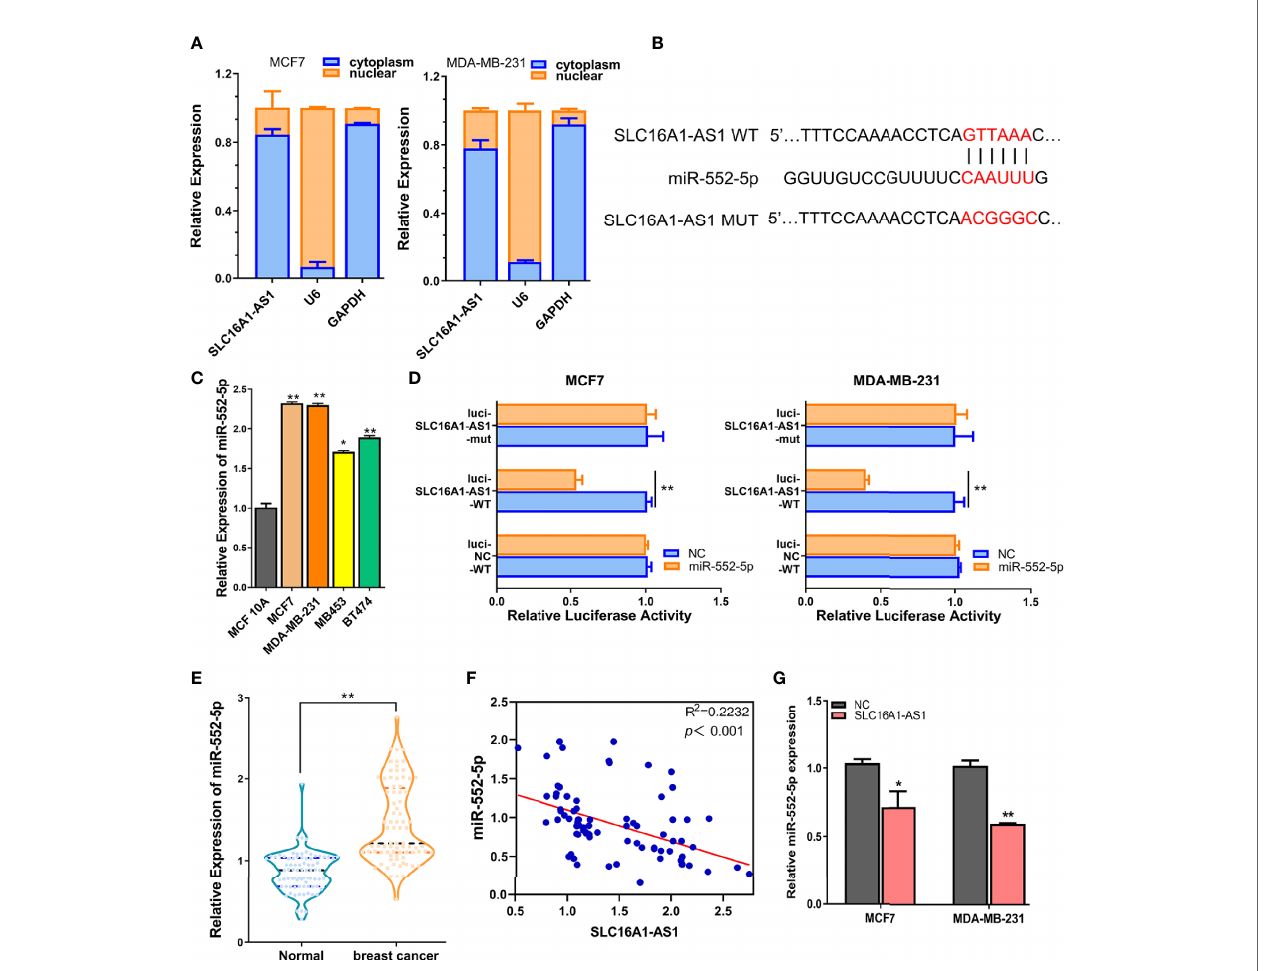
FIGURE 4 | SLC16A1-AS1 is a sponge for miR-552-5p. (A) Cellular sublocalization of SLC16A1-AS1 in MCF7 and MDA-MB-231 cells was investigated with nuclear and cytoplasmic separation assay, and GAPDH and U6, respectively, acted as internal controls for cytoplasmic and nuclear expressions. (B) Diagram indicating the prospective binding sites for miR-552-5p with SLC16A1-AS1 predicted by miRDB (http://mirdb.org/) and mutated information of prospective miR- 552-5p binding sites. (C) miR-552-5p expressions were signi fi cantly higher in MCF7 and MDA-MB-231 cells than in MCF 10A cells analyzed by qRT-PCR. (D) Dual-luciferase activities in MDA-MB-231 and MCF7 cells in the presence of negative control (NC), wild type (WT), or mutated (mut) reporter of SLC16A1-AS1 with miR-552-5p or without (NC) miR-552-5p mimics. (E) miR-552-5p expression was considerably higher in BC tissues versus the paired paracancerous tissues from 80 BC patients (the same specimens used in Figure 1A ). (F) miR-552-5p expression level was signi fi cantly negatively related to SLC16A1-AS1 expression level in 80 BC tissues by Spearman correlation coef fi cient analysis (the same specimens used in Figure 1A ). (G) miR-552-5p expression was con fi rmed to be negatively regulated by SLC16A1-AS1 expression after measuring miR-552-5p levels in MDA-MB-231 and MCF7 cells with SLC16A1-AS1 overexpression. * p < 0.05, ** p <